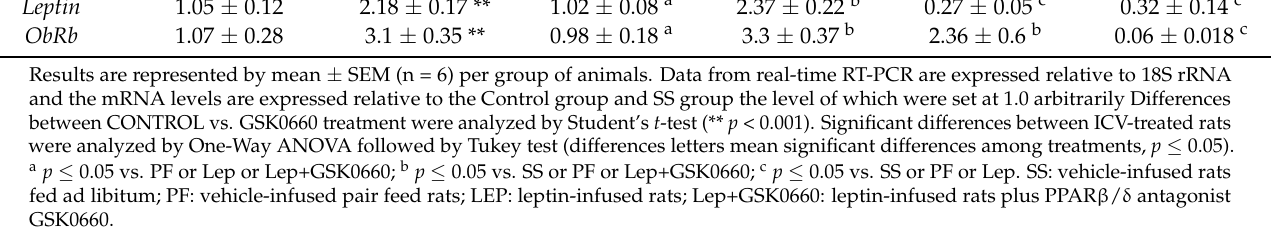
Table 2. Gene expression of leptin and ObRb leptin receptor in epididymal white adipose tissue. Gene